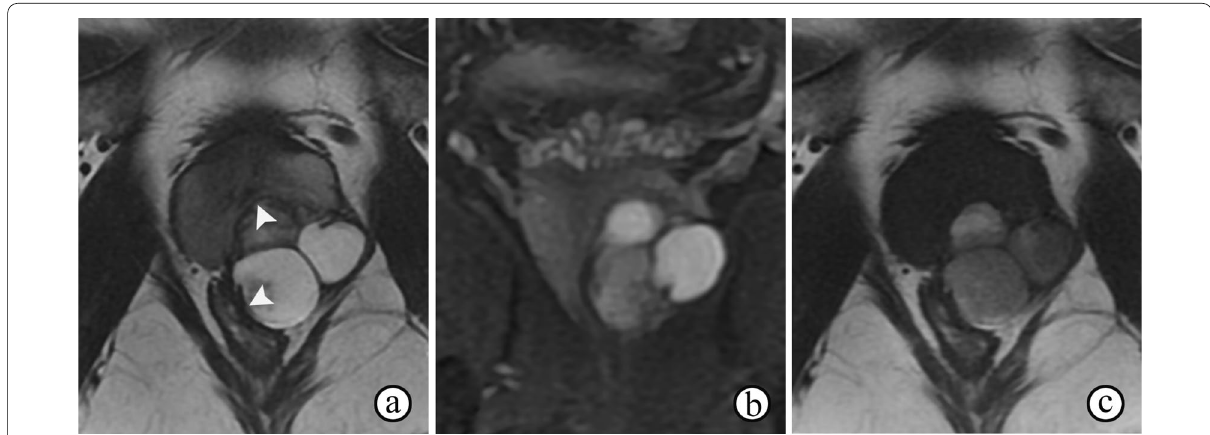
Fig. 17 Prostatic cystadenoma in a 36-year-old man. a, b Axial T2- and coronal fat-suppressed T2WI show a multilocular cystic mass with inhomogeneously high signal intensity from the left lobe of prostate, compressing the tissue of the prostate and rectum (arrowheads on a ). c Axial T1WI shows inhomogeneous hyperintensity of the cysts suggesting hemorrhage or proteinaceous